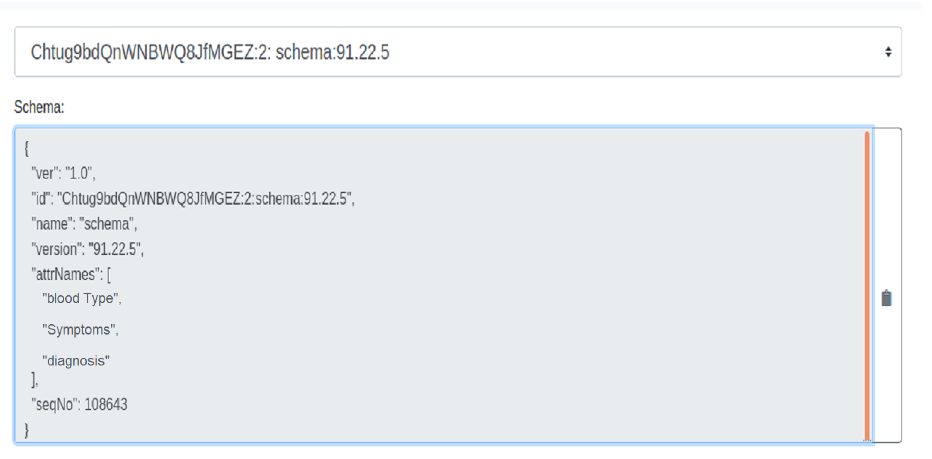
Figure 5. Bob sends a request to the laboratory for a subset of his attributes in Hyperledger Indy.